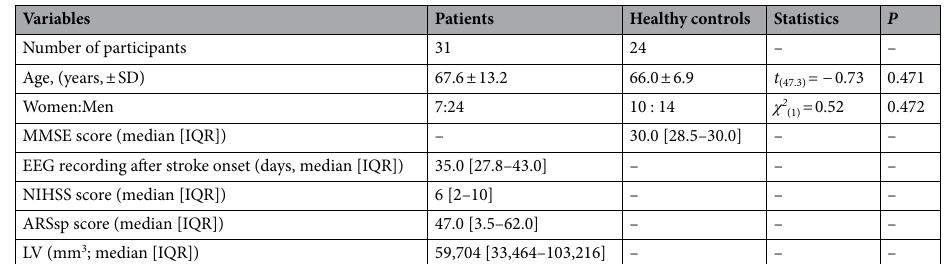
Table 1. Demographic and clinical characteristics of the participants. ARSsp Aphasia Rating Scale speech, EEG electroencephalography, IQR interquartile range, LV lesion volume, MMSE mini mental state examination, NIHSS National Institutes of Health Stroke Scale, SD standard